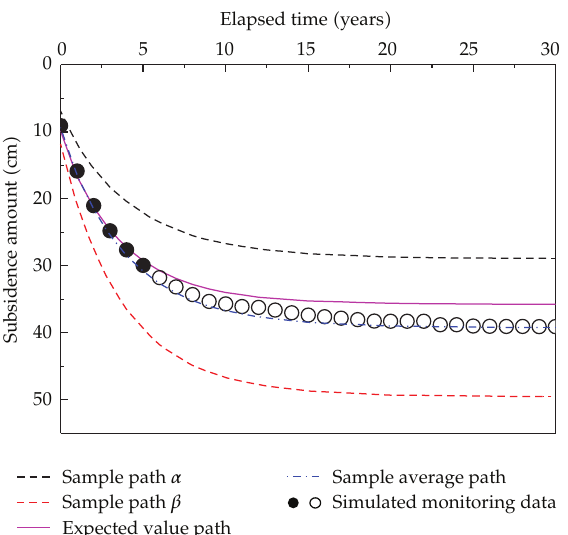
Figure 3: Simulated monitoring data and sample